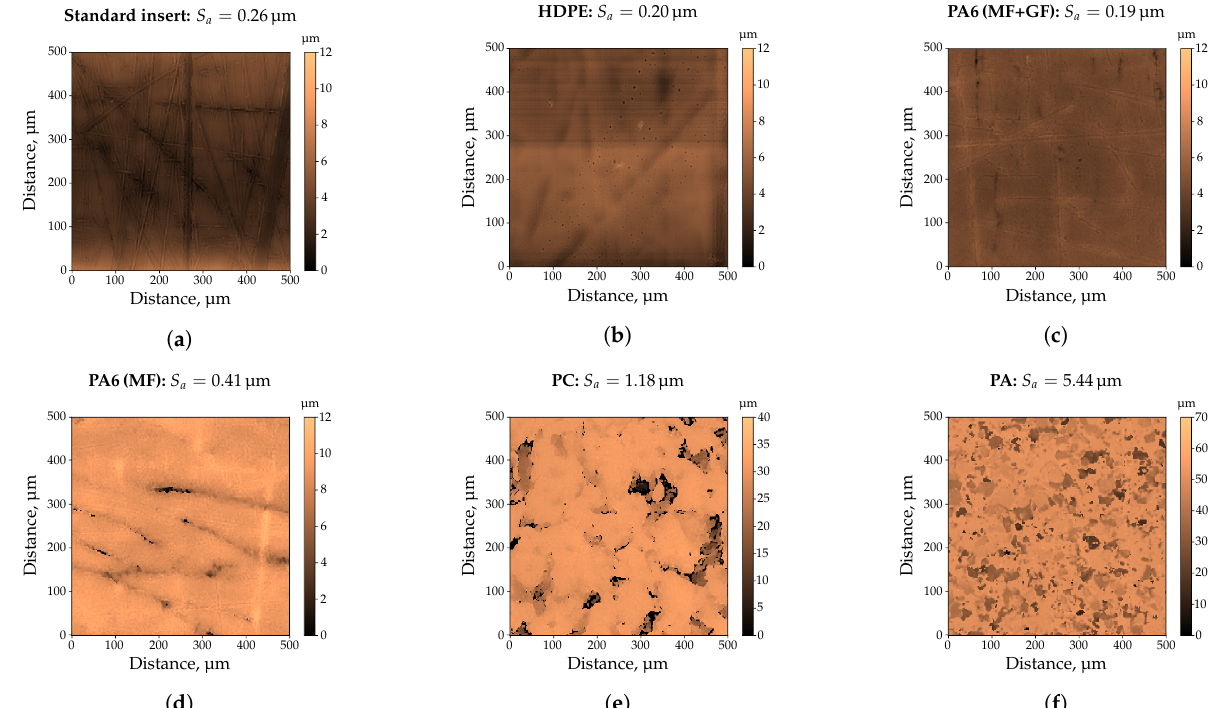
Figure 2. Preliminary investigations on the impression quality of commercially available thermoplastics by means of a confocal microscope. A cut-off wavelength of 71 µ m was selected. ( a ) Standard insert: S a = 0.26 µ m. ( b ) HDPE: S a = 0.20 µ m. ( c ) PA6 containing mineral filler (MF), and glass fiber (GF): S a = 0.19 µ m. ( d ) PA6 containing mineral filler (MF): S a = 0.41 µ m.